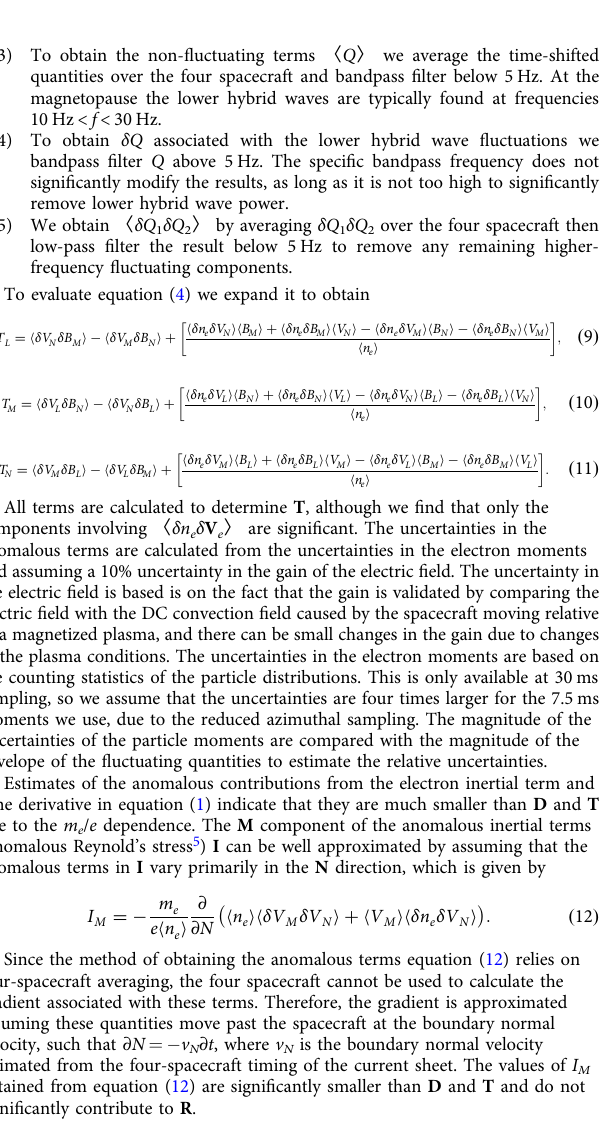
¼ j T j . The horizontal and max max